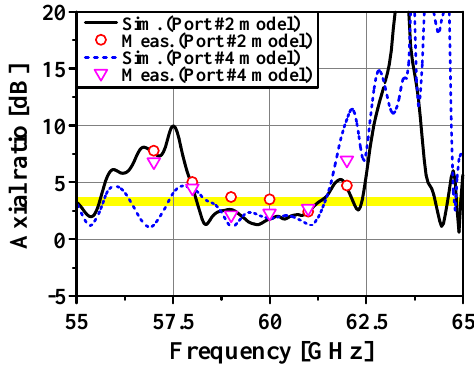
Figure 19. Measured axial ratio of the antenna for port 2 model and port 4 model.